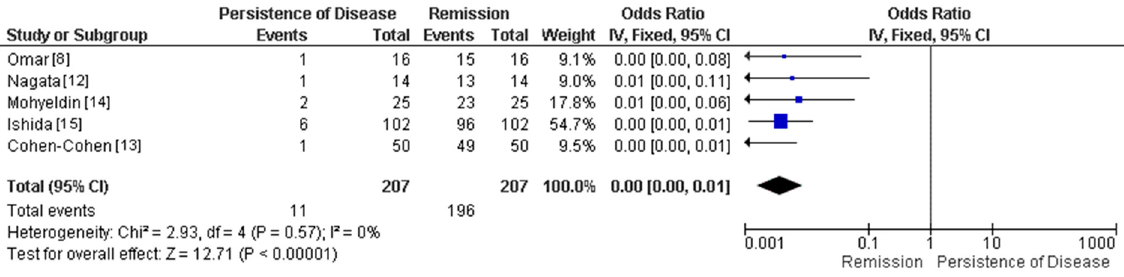
Figure 2. Forest plot of remission vs. persistence of disease of the 4 selected studies included in this